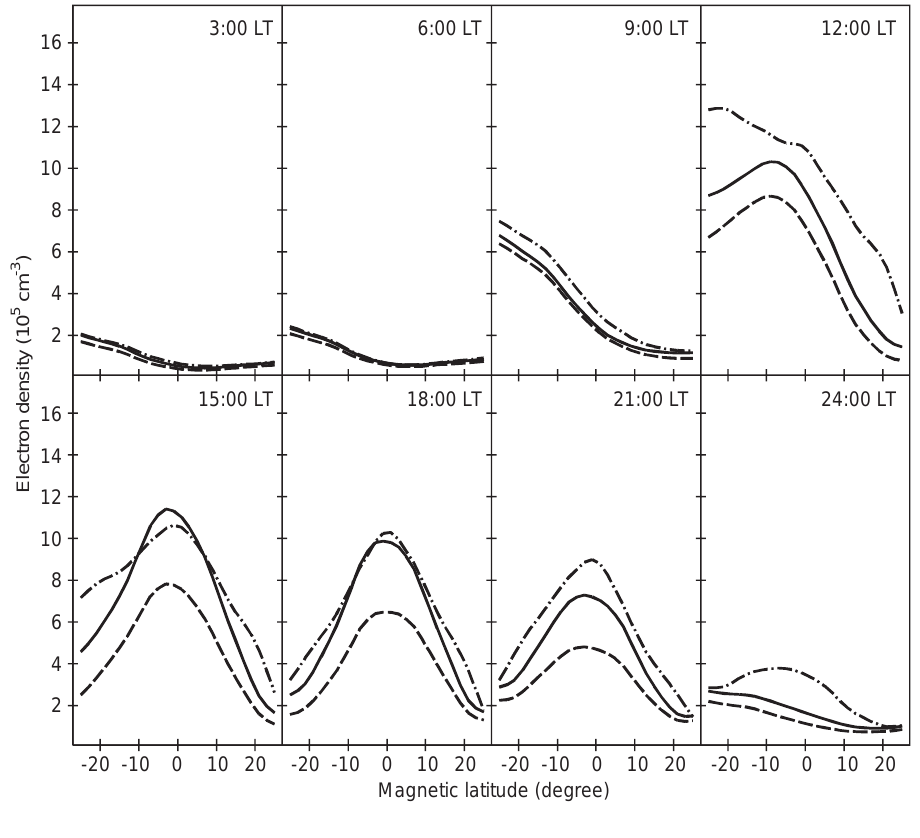
Fig. 9. Latitudinal variations of the modelled electron density, at inter- vals of 3 h, for December solstice. The solid curves are the same as the short-dashed curves of Fig. 4. The dashed and dot-dashed curves are from the calculations in which the daytime (08:00–18:00 LT) pole- ward neutral wind and the upward E (cid:2) B drift velocity are multiplied by the factor 2, respectively. Other model inputs are the same as for the previous sets